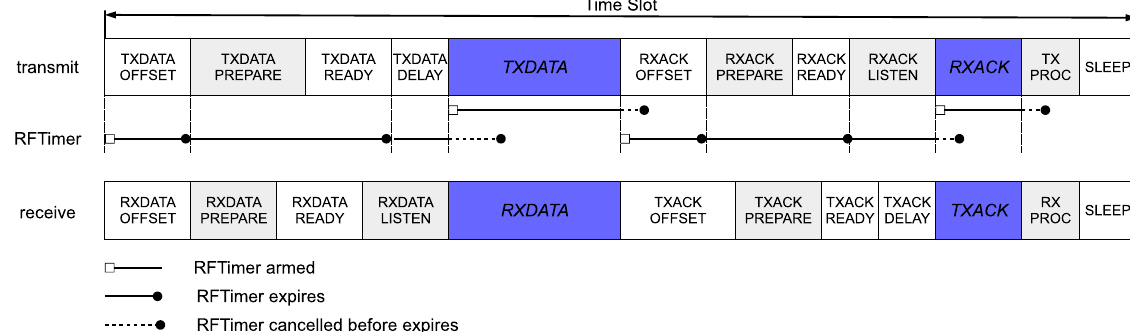
Figure 6. A TSCH slot is implemented as a state machine. The different states of a tramsmit and a receive slot are shown at the top. The RFTimer is used to transition from one state to the next, kicking off different actions in the radio (e.g., loading a frame in the transmit buffer) without intervention from the